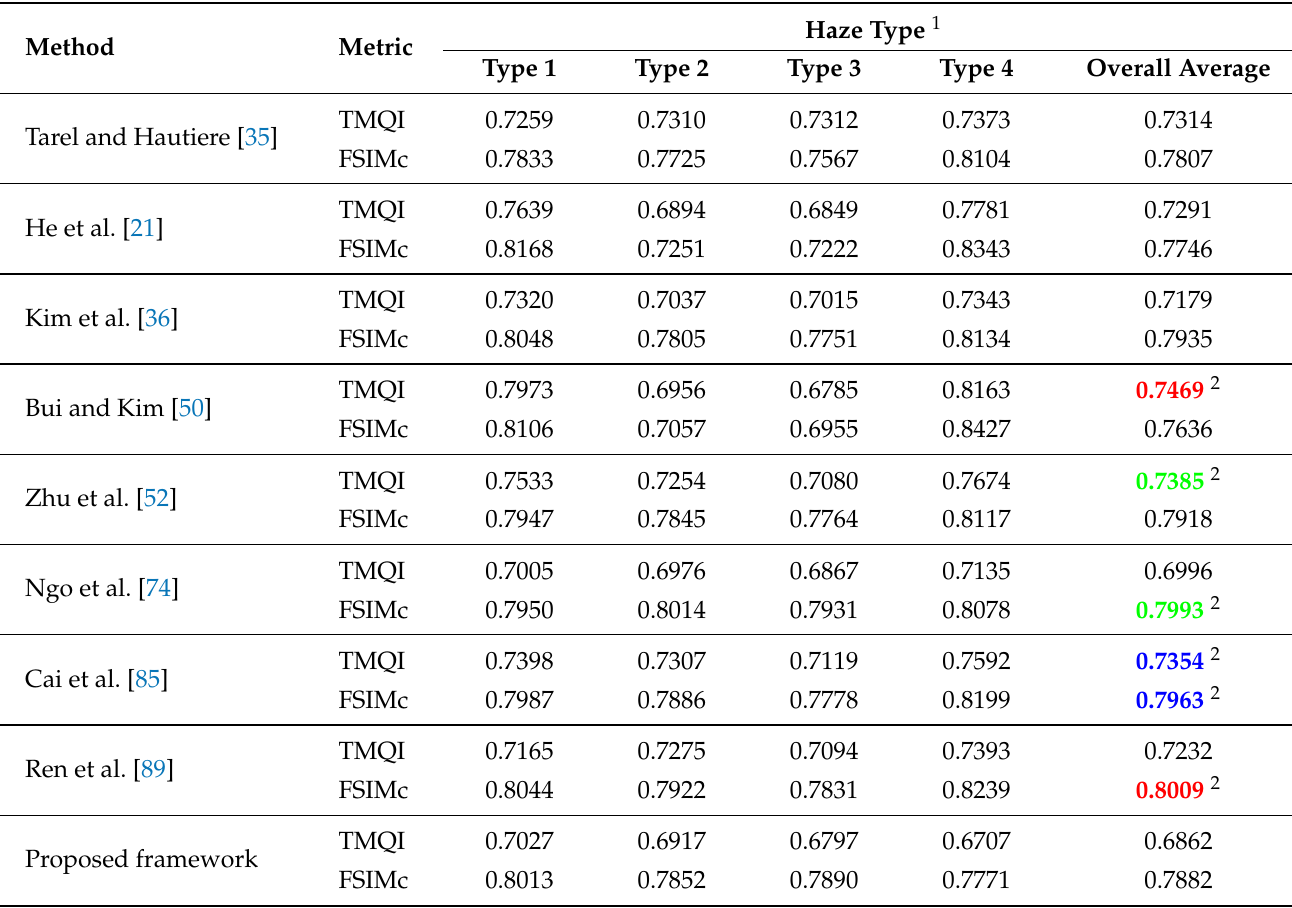
Table 5. Quantitative evaluation results of different dehazing methods on the FRIDA2 dataset.